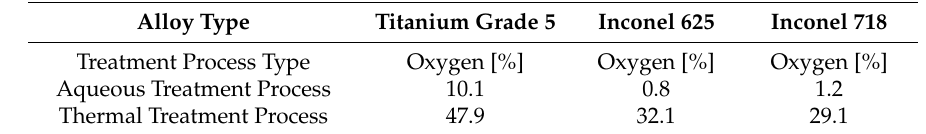
Table 6. Oxygen distribution on the surface of swarfs in aqueous treatment process and thermal treatment process.